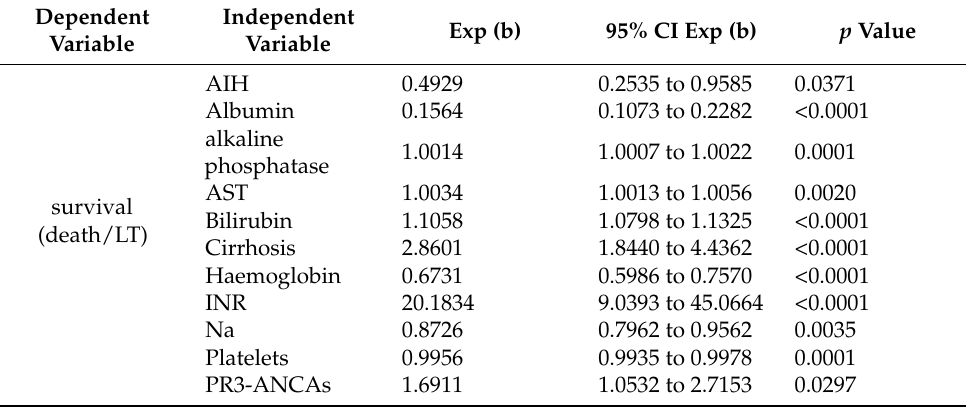
Table A2. Univariate regression analysis of independent variables for the risk prediction of poor survival (liver transplantation or death) in 309 patients with primary sclerosing cholangitis. Abbrevia- tions : autoimmune hepatitis, AIH; aspartate aminotransferase, AST; confidence interval, CI; relative risk of event, Exp (b); international ratio,